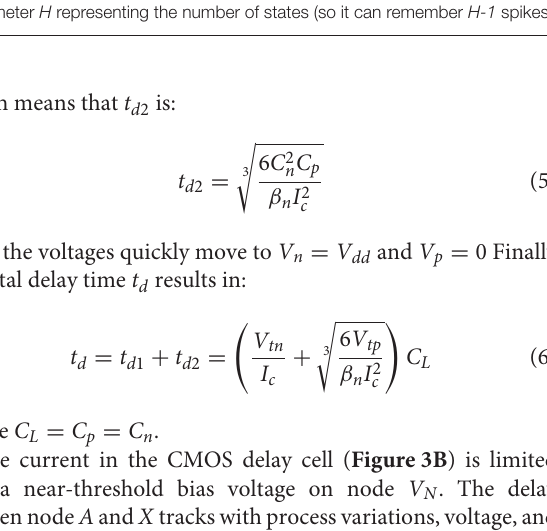
FIGURE 2 | (A) Logic block diagram of spike arbiter (thick lines represent many parallel signals). (B) Logic block diagram of the local oscillator and the timing of the self-generated clock pulses. (C) Logic block diagram of the input edge detector (edge-triggered) implemented through an S/R circuit. It is parameterizable with a parameter H representing the number of states (so it can remember H-1 spikes). Here we show the case in which (H = 2), i.e., the most straightforward